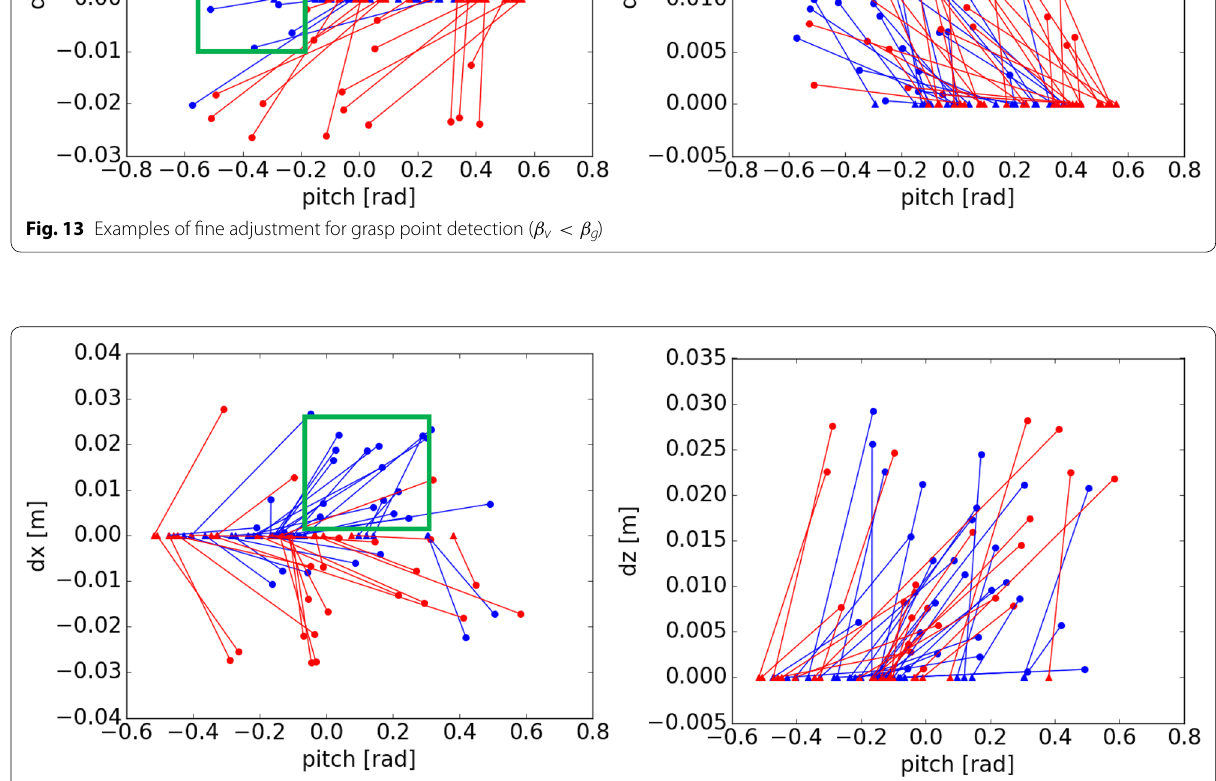
Fig. 14 Examples of fine adjustment for grasp point detection ( β v > β g